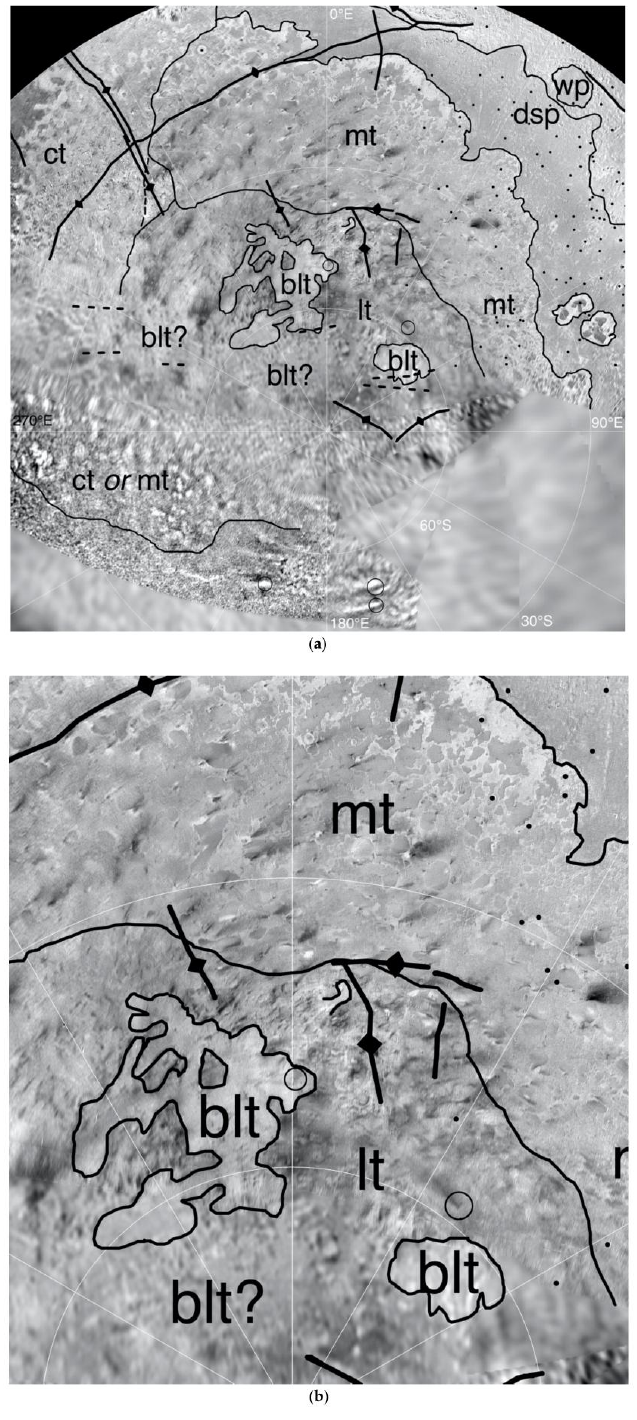
Figure 22. ( a ) Polar stereographic map of Triton southern hemisphere; ( mt ) macular terrain, ( lt ) lineated terrain, and ( blt ) bright lobate terrains that appear to embay lineated terrains in two large units and possible southern outliers. Note diffuse dark fan-shaped deposits in ( mt ). Terrains extending from the north include (upper right) etched plains, ( ct ) cantaloupe terrain, and ( dsp ) dark smooth plains. Open circles indicate known plume sources, heavy lines are linear features, heavy dashed lines are approximate locations of limb haze, and black dots are (not-to-scale) impact craters. Remapped from [30] and [8]. Some terrain boundaries are indistinct in the images and all boundaries are approximate, intended as a guide for the reader. Central longitude 0 ◦ E is to top. ( b ) Enlargement of central section of Figure 22a, showing southern most regions for